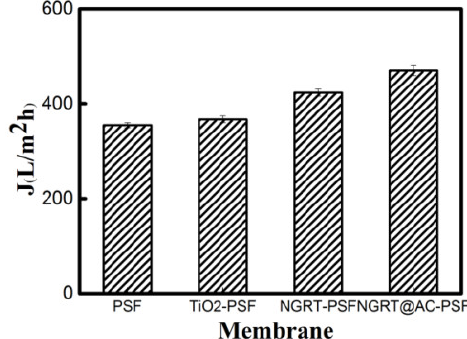
Figure 9. The pure water flux of the as-prepared membranes.